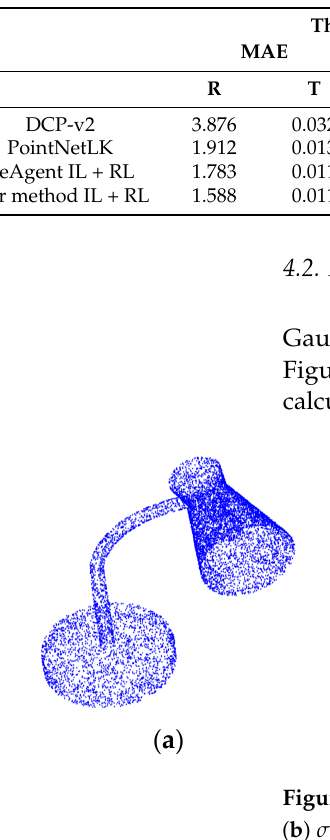
Table 1. Registration Results on ModelNet40.